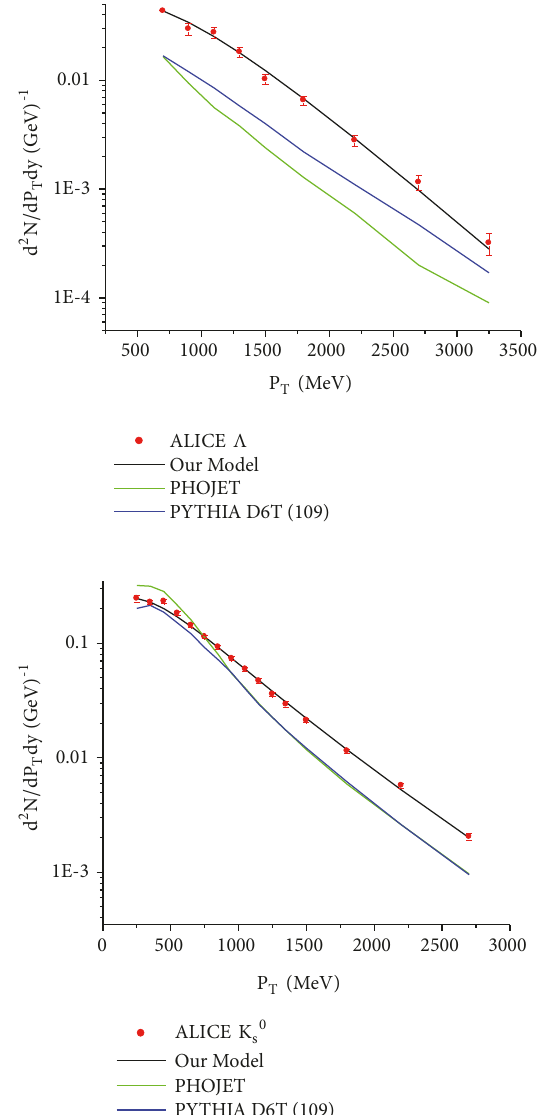
Figure 7: Comparison of our model results with PHOJET and PYTHIA D6T (109)